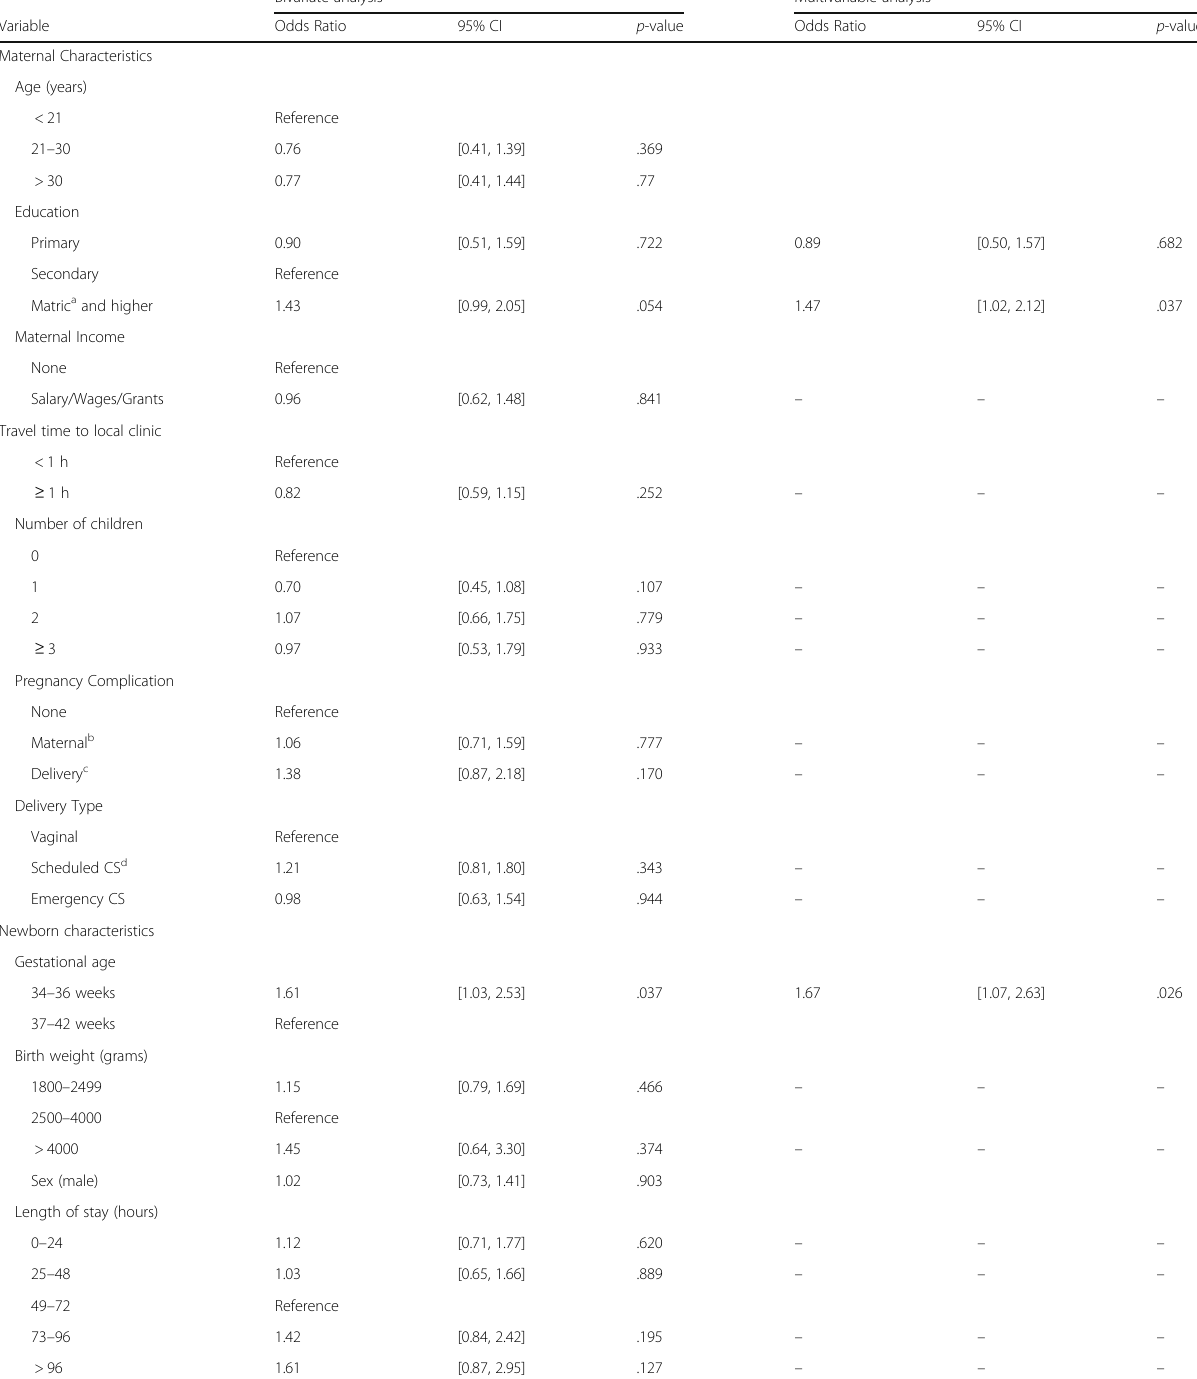
Table 3 Factors associated with newborn follow-up visit after hospital discharge within seven